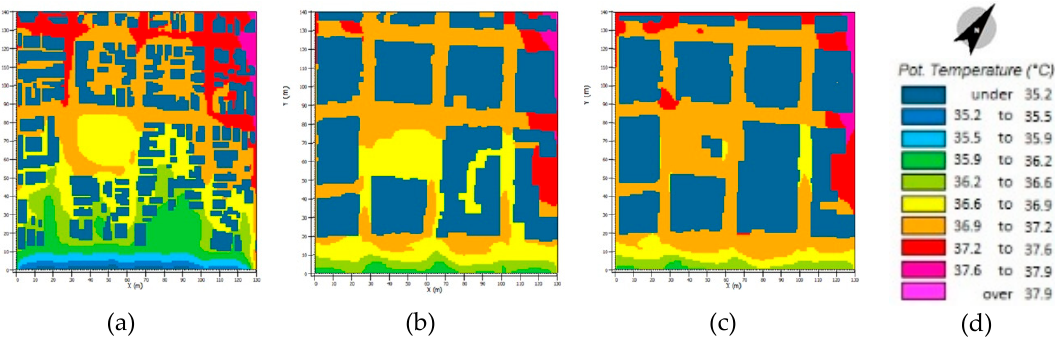
Figure 4. Air temperature (Ta) results for January 2018 (average), 10 a.m.: ( a) Sprawl Morphology (urban form data: 1930); ( b ) Medium Morphology (urban form data: 1950); ( c ) Density Morphology (urban form data: 2018); and ( d ) Color scale and north.